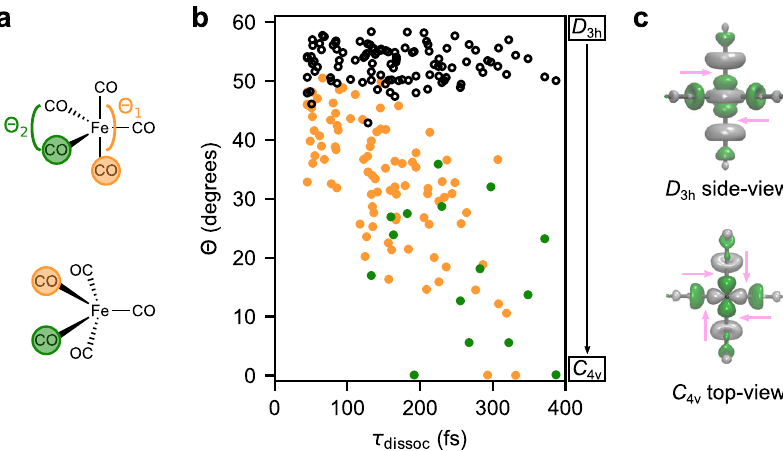
Fig. 5 Correlation of angular distortion, from D 3h geometry to near C 4v geometry as measured by decrease in Θ , and time taken for CO release. a Schematic representation of degrees of freedom in the angular distortion parameter Θ = Θ 1 − Θ 2 , introduced in Fig. 2a, involving transition from D 3h geometry to near C 4v geometry; followed by release of CO. The green and orange spheres denote the axial and equatorial ligands which become equivalent upon angular distortion to the nearly C 4v geometry. b Scatter plot of the smallest value of Θ , before τ dissoc , versus τ dissoc for all 110 singly dissociative trajectories. The orange and green solid dots represent release of axial and equatorial CO ligands, respectively. The hollow black dots show the initial distribution of Θ obtained from the Wigner distribution. c The excited singly occupied molecular orbital involved in the the dissociative MC states at ground state D 3h geometry (top) and in the near C 4v geometry (bottom) which is also the optimized geometry for the S 5 state. The pink arrows for both the cases indicate regions of anti-bonding overlap which effectuates the CO